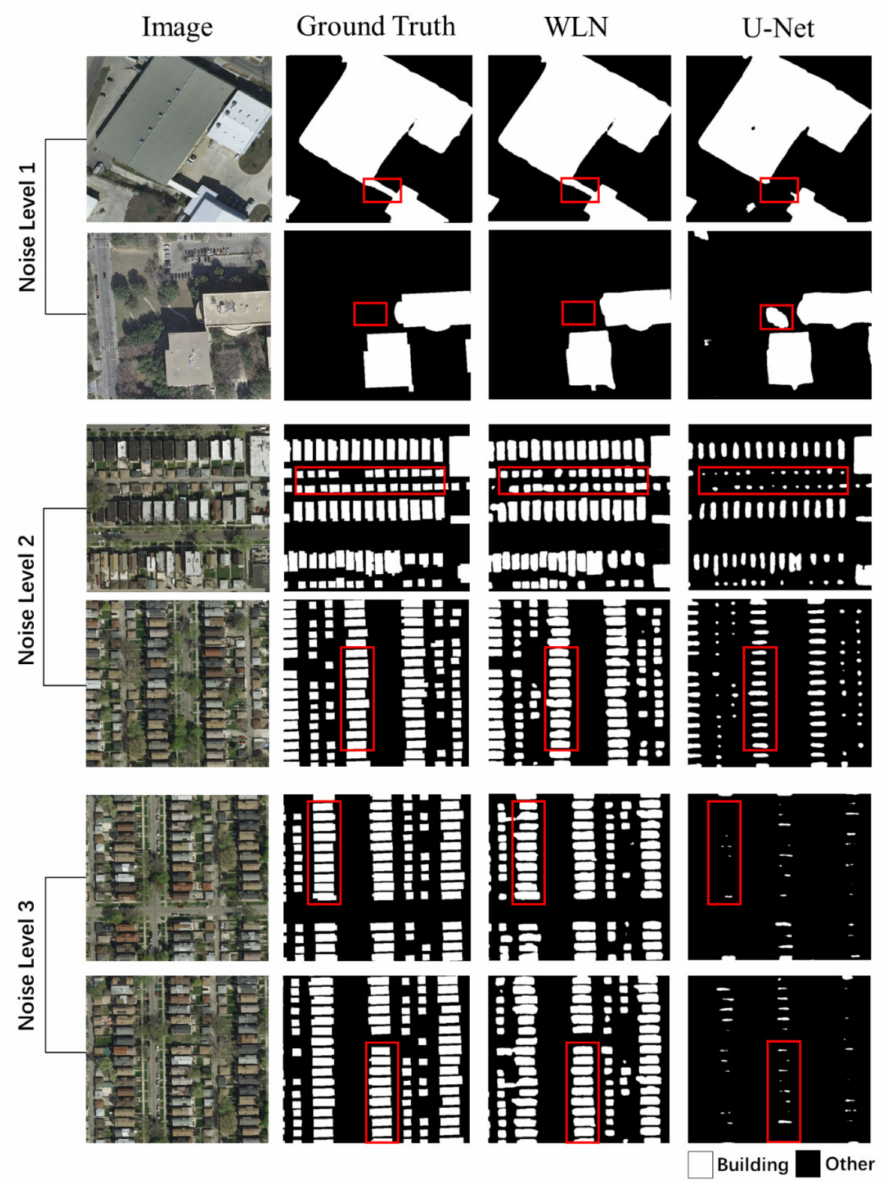
Figure 11. Extraction results of WLN and U-Net under different noise levels with a 50% noise rate of eroded